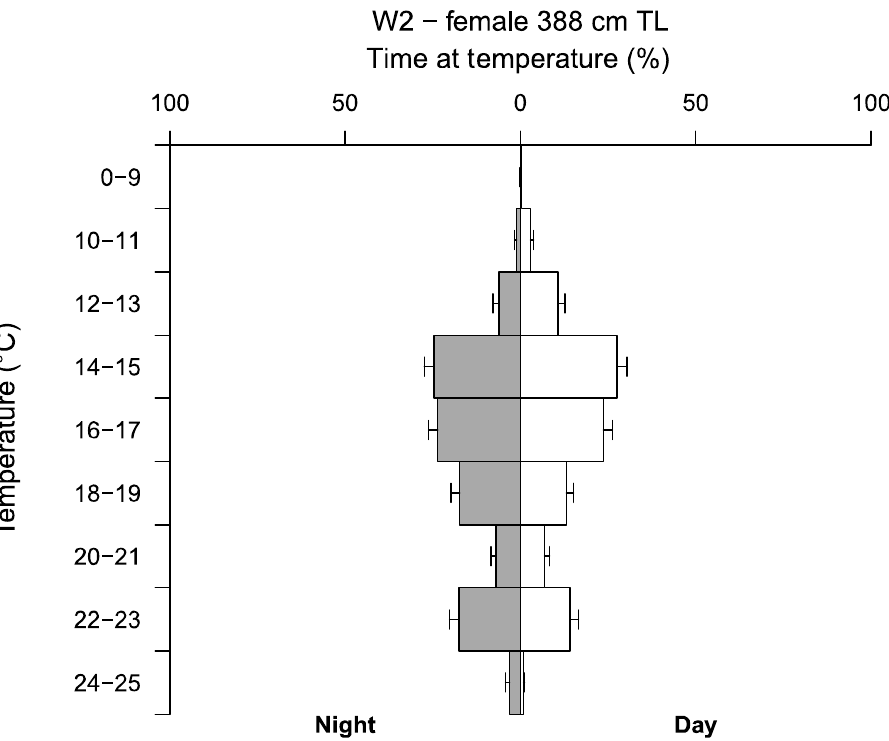
Figure 5. Time spent (%±SE) at temperature (°C) during the day (white bars) and night (grey bars) for one white shark ( C. carcharias ) individual (W2).